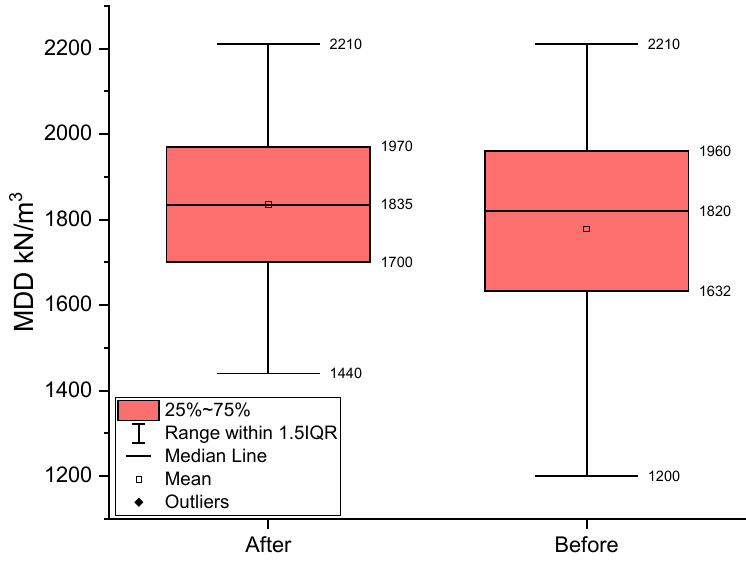
Figure 7. Distribution of MDD before and after outliers from other features were dropped. Evaluation of the model’s performance using the aforementioned statistical metrics validates that the adopted algorithms predict compaction and strength properties of the soil with relatively low error on new data. In fact, these results are solely valid for the dataset that was used. If alternative data were used, the performance of each algorithm might differ. It is also worth noting that neither OEM nor ANN provide superior results in all models during training and test. There are cases where OEM provides better results than ANN, and vice versa. Assessing the performance of multiple machine learning algorithms for the prediction of OMC, MDD, and UCS is imperative to distinguish which algorithm performs best. This is because every machine learning algorithm’s relative prediction capacity is largely determined by the data and characteristics of the problems under consideration. It is impossible to distinguish the algorithms that excel at a given problem without experimenting with them. Table 4 depicts the optimized hyperparameters of the OEM and ANN models. To optimize the performance of the OEM-based models, five hyperparameters were consid- ered, as presented in the model training section. Hyperparameter tuning was performed using Bayesian optimization in combination with a 10-fold cross-validation technique to determine the ideal combination of values of hyperparameters that minimizes the mean- square error. Bagged regression trees produced the best results for OMC and MDD models. LSBoost provides a better result for UCS prediction with a minimum leaf size of 2 and a learning rate of 0.157. The number of predictors to sample and learners for each model is different. Table 4. Hyperparameters that yielded the optimal